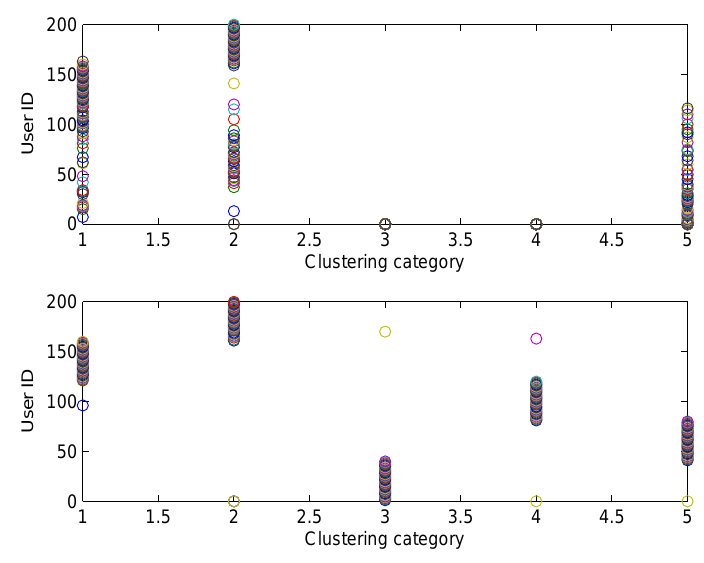
Figure 5. Comparison of user clustering.